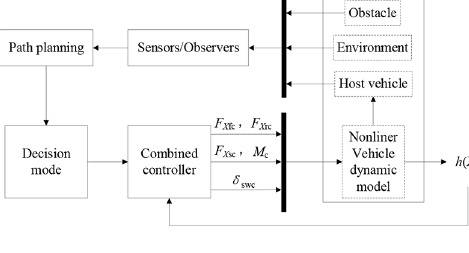
Figure 8 Structure of the safe lane-change control system